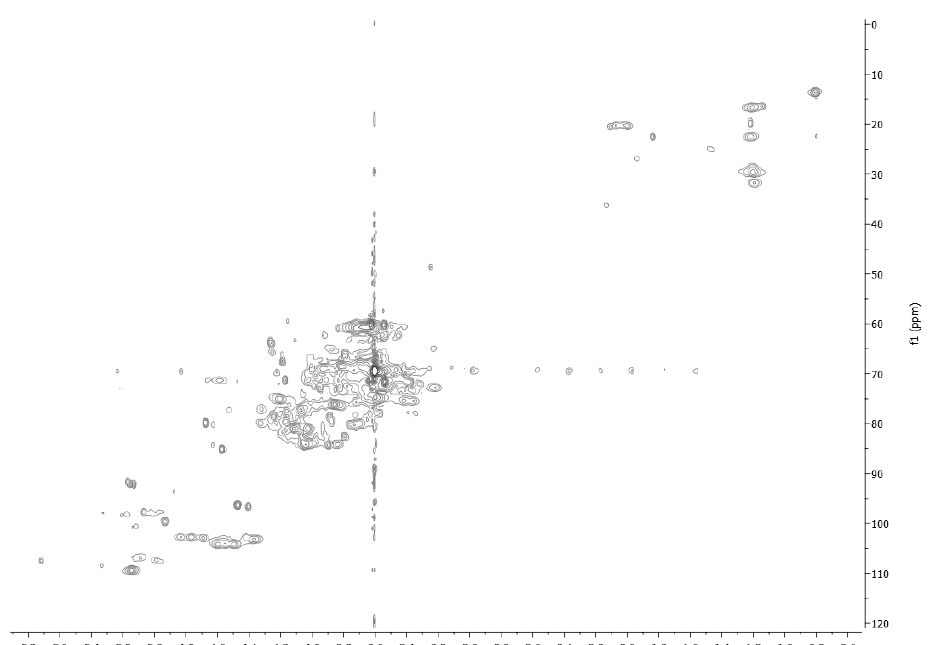
Figure 7. 1 H NMR spectrum of EPSC.2, recorded at 700 MHz in D 2 O. 2D HSQC spectrum of fraction EPSC.2 (Figure 8) confirmed the results obtained by 13 C NMR in solid state recorded on EPSC and 1 H NMR in D 2 O solution. In fact, signals at δ 110– 95 ppm and δ 85.0–65.0 ppm typical of anomeric and hydroxylated carbons and signals at δ 15.0–30.09 ppm of 6-deoxy carbons were observed [44,45]. However, the spectrum showed